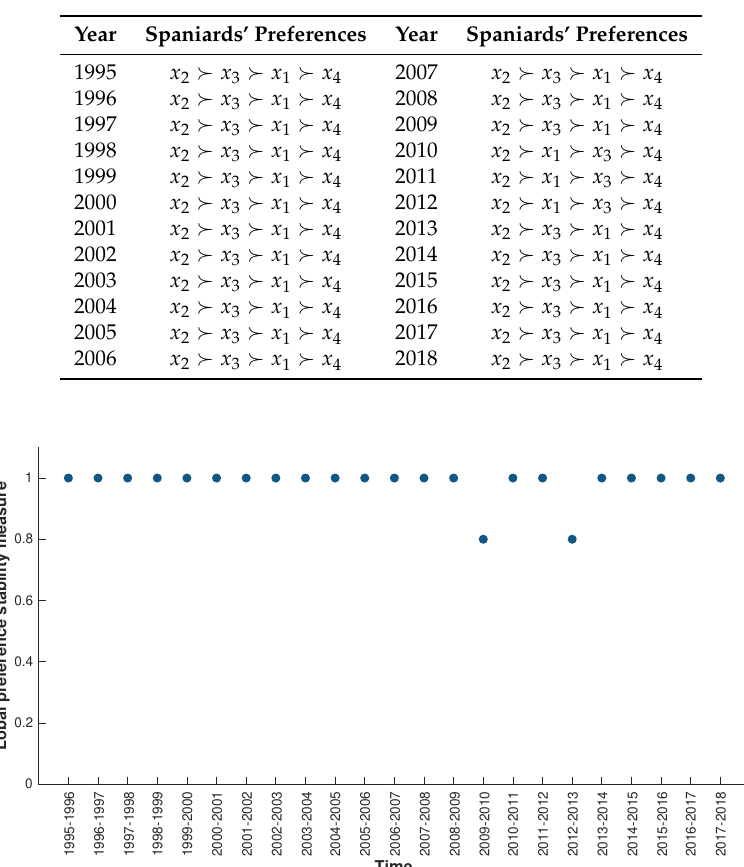
Table A1. Temporal preferences established by Healthcare Spanish Barometer for Question 1.